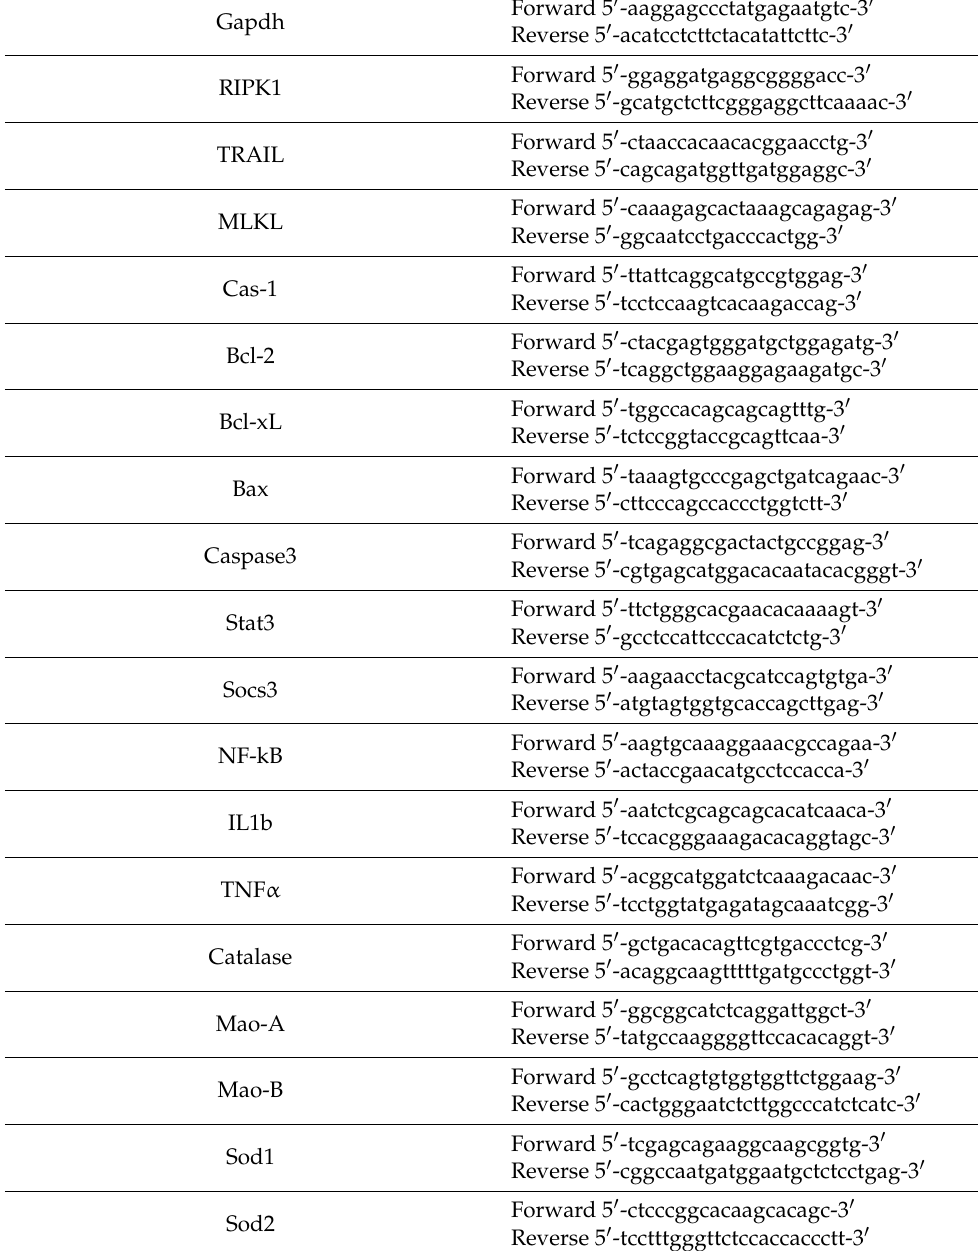
Table A1. Primer sequences for real-time polymerase chain reaction